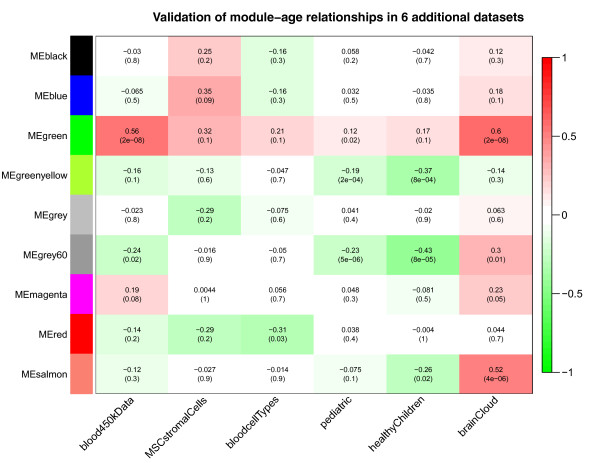
Correlating consensus modules with age in the six validation data sets. Each row corresponds to a consensus co-methylation module eigengene (defined in Figure 3). The columns correspond to the age variable in each of the six validation data sets. Each cell reports correlation coefficient between the eigengene and age (top) and the corresponding P-value (bottom). Cells in the table are color coded using correlation values according to color scale on the right. All of the reported modules were significantly preserved in the Dutch WB data measured on the Illumina 450 K array (Additional file 3). The green module has a particularly strong positive correlation with age in the Dutch 450 K blood data (r = 0.56, P = 2E-8) and in the brain cloud (pre-frontal cortex) data sets (r = 0.6, P = 2E-8). The age correlations for the green module are positive in all of the data sets (most of the marginally significant P-values reflect the low sample size in the respective data sets or the low age range).